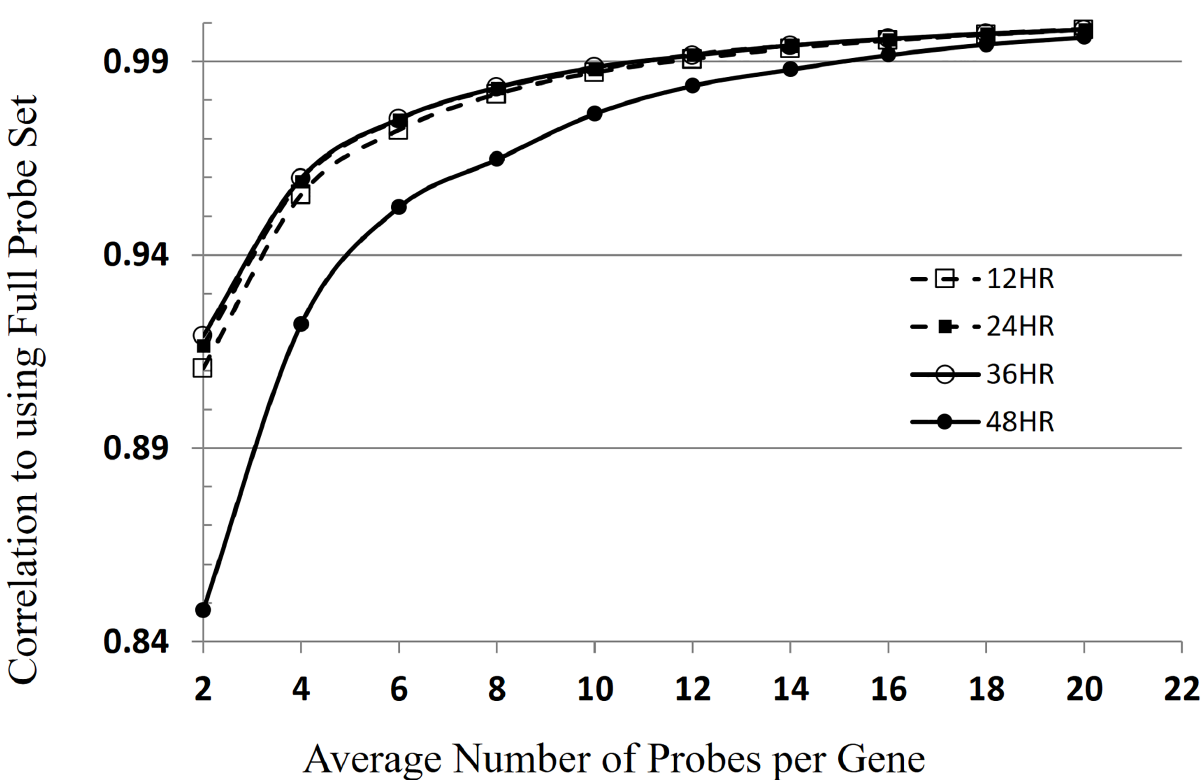
Fig 5. Determining the ideal number of probes per gene. Simulation of the minimumnumber of probesper generequiredto reproduce geneexpressionlevels obtained by using the full probe-set per gene on the exon array. For each time point, gene expressiondata was obtained by averagingsignalintensity across a given subset of probes(2 to 20) and in each case the genome-wide correlationbetweenthe expression level obtainedwhen using a subset of probesand the full probe set was determined. To obtainhighly correlatedsignalsbetween replicates, a minimumof 10–12 probes per gene is